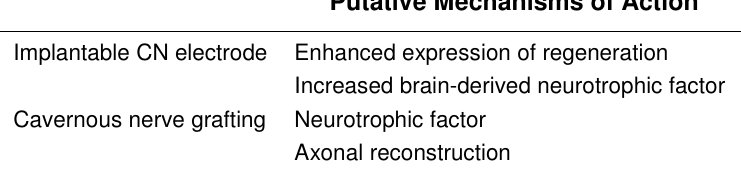
Surgical Therapies for Improving Erection Recovery Putative Mechanisms of